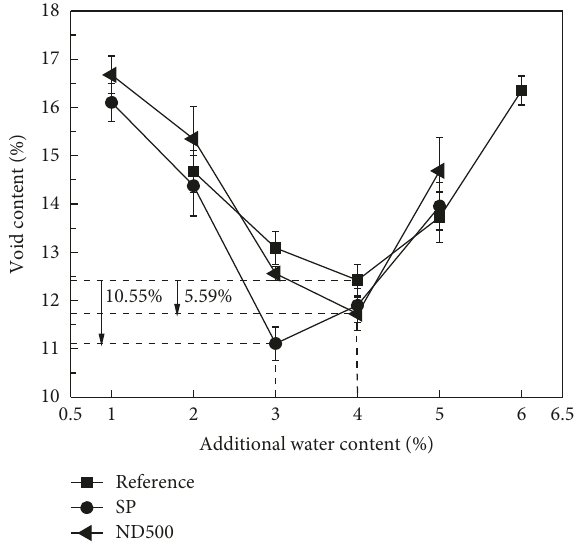
Figure 6: The void content of CRME with different